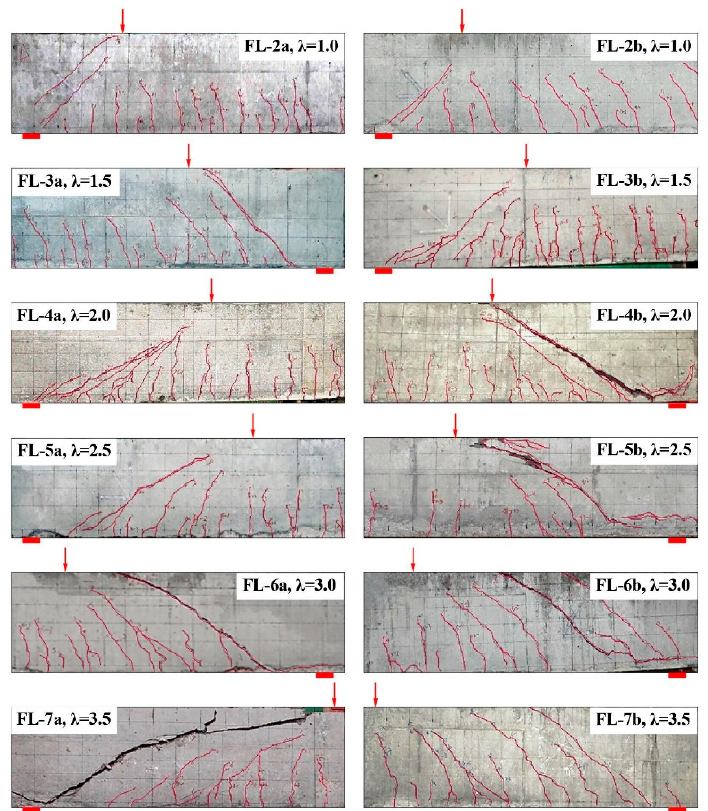
Figure 4. Crack distribution of test beams with varying λ .